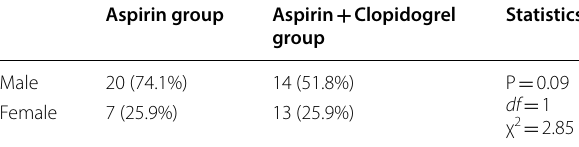
Table 1 Sex ratio of study participants in each group Aspirin group